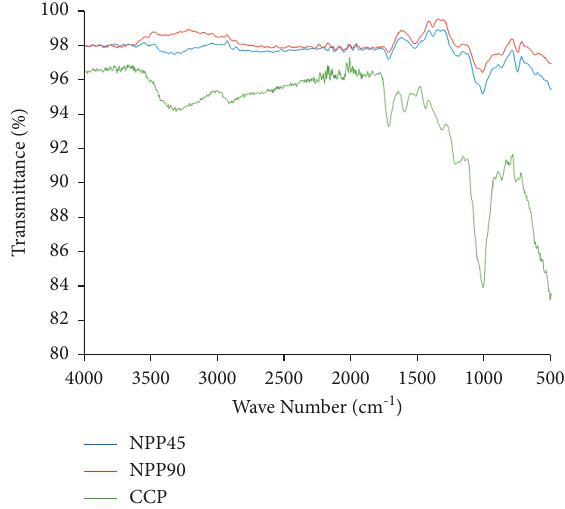
Figure 4: IR spectra of CPP, NPP 45, and NPP 90.